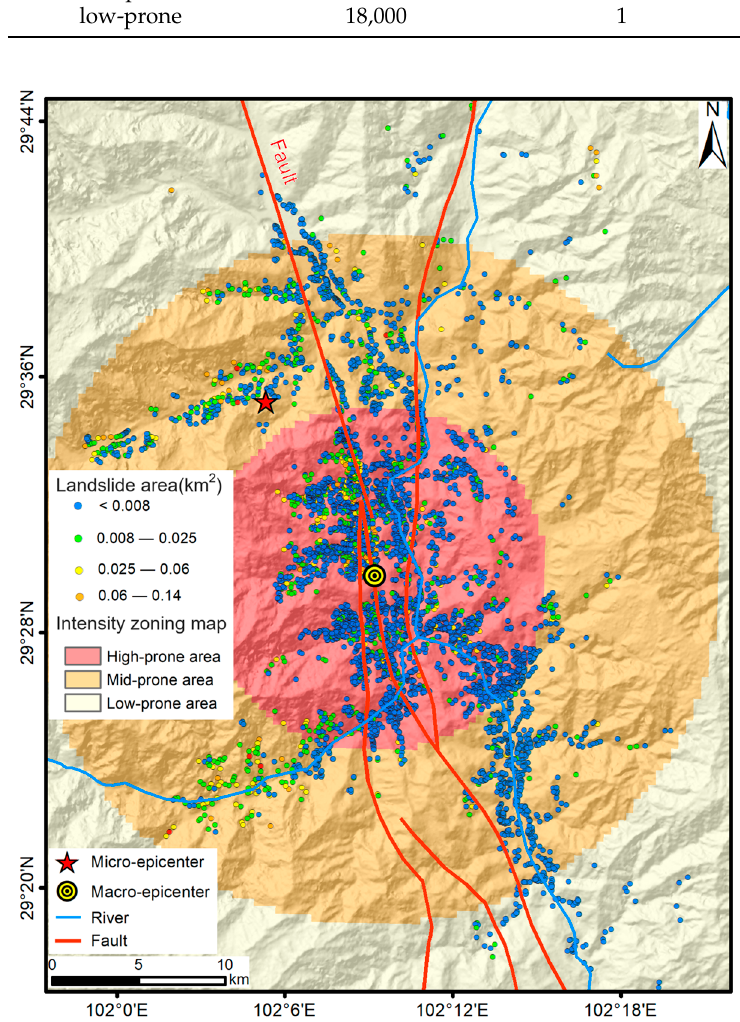
Figure 9. Landslide intensity map.